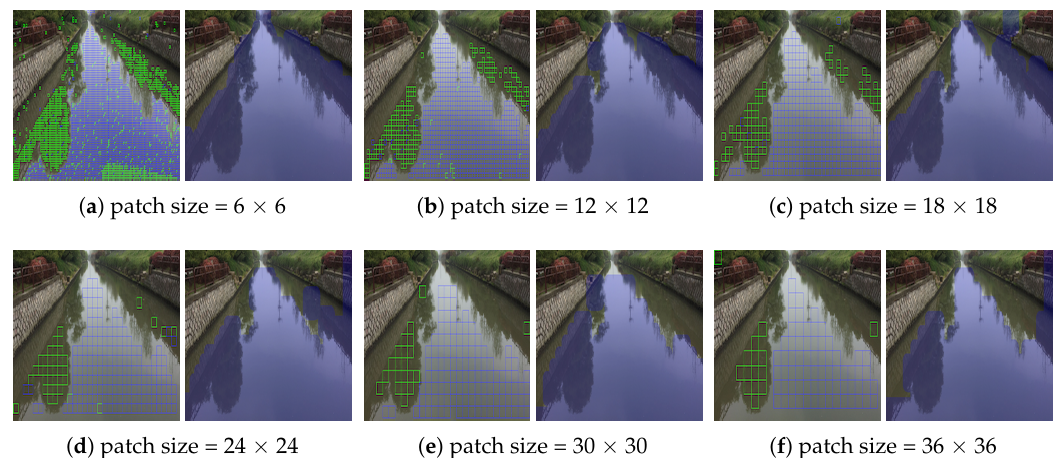
Figure 15. Segmentation results under different patch sizes from 6 × 6 to 36 × 36 pixels used in the proposed algorithm.